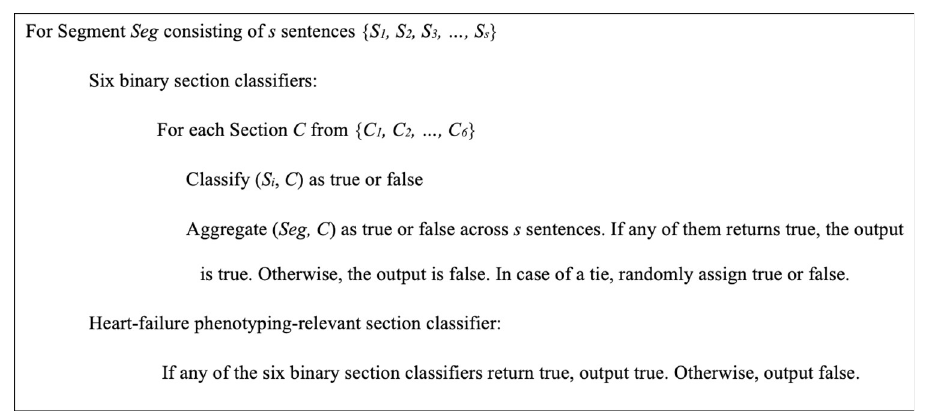
Fig 2. The algorithm of section